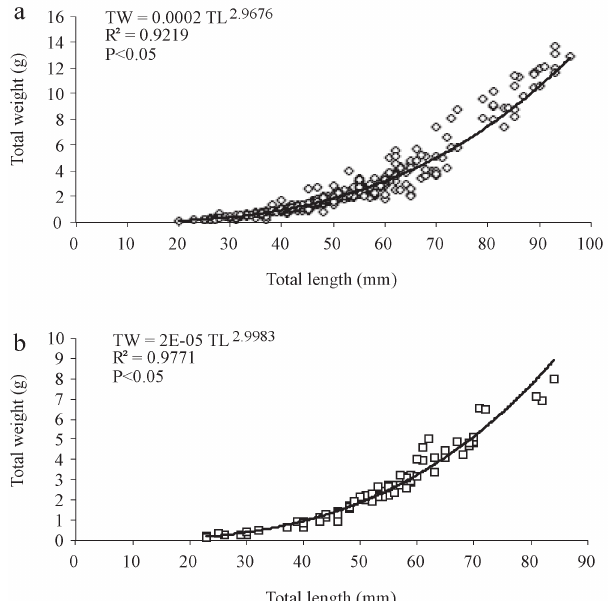
Fig. 4. Length-weight relationship for females (a) and males (b) of Poecilia sphenops .